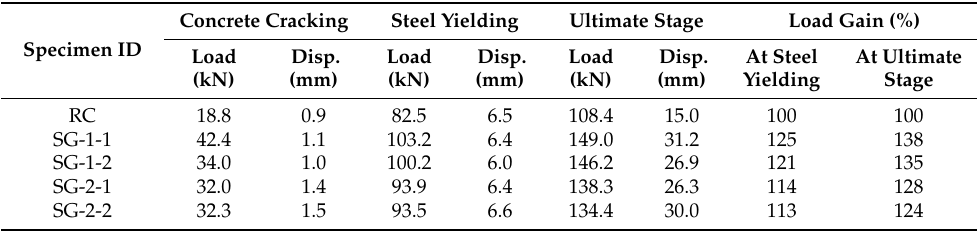
Table 5. Results of failure test for RC slab specimens.